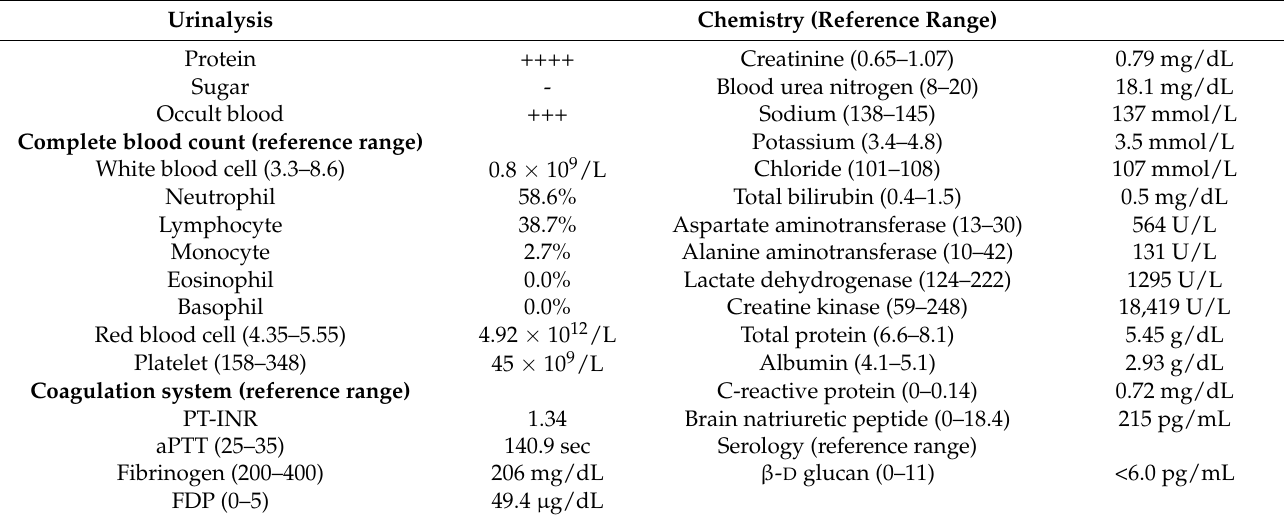
Table 1. Laboratory data on the admission of our